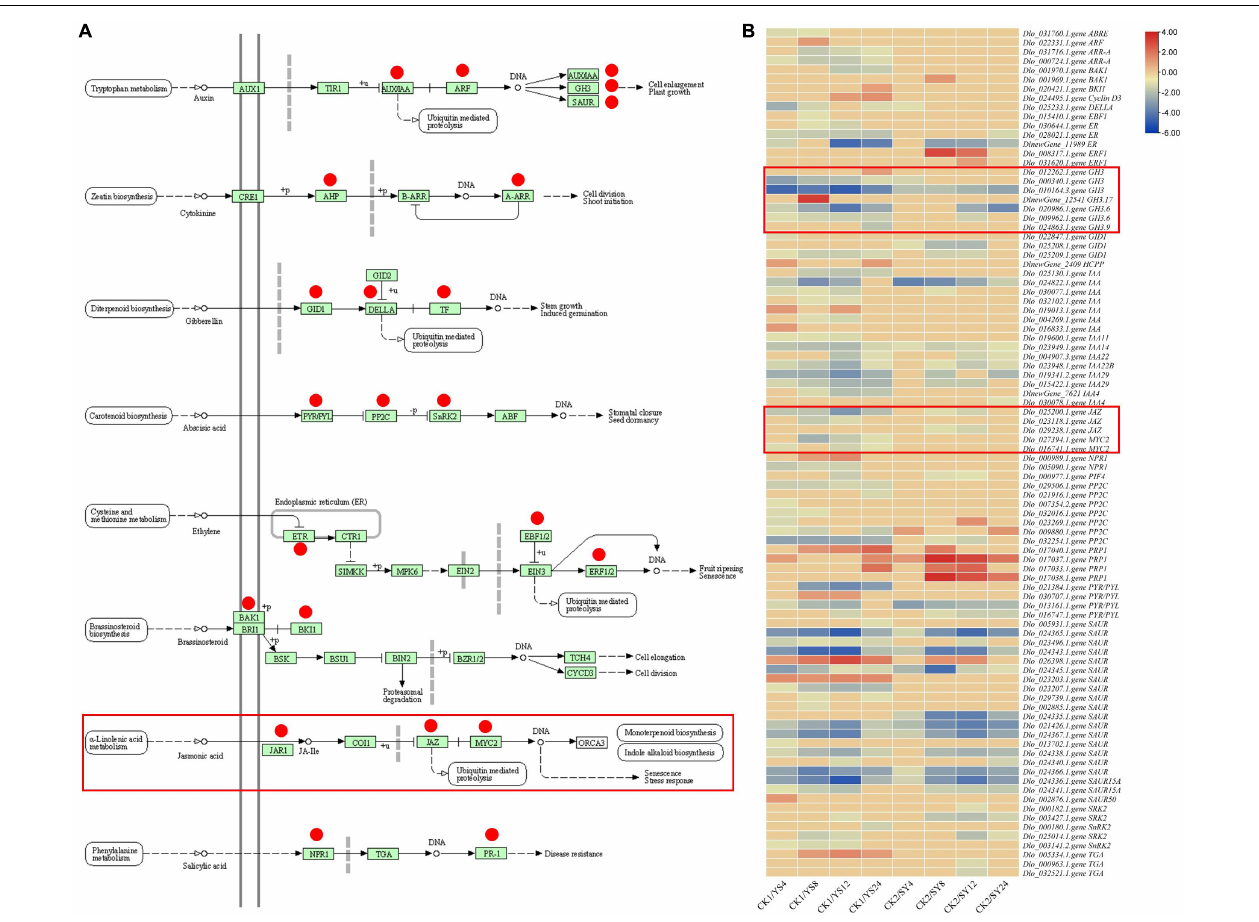
FIGURE 6 | Comparison of hormone signal transduction pathway in the two longan pollination combinations. (A) Regulation of plant-hormone signal transduction pathway in two longan pollination combinations, i.e., YS and SY, compared to their respective controls. Y, Yiduo; S, Shixia; CK1, Yiduo sepal-pistil before pollination; CK2, Shixia sepal-pistil before pollination. The numbers with treatments represent the time (hour) after pollination. The red circles in the left panel represent the genes that were differentially regulated. Red rectangles represent the genes related to Jasmonic acid. (B) The right panel shows the heatmap of log2 fold change values of the DEGs between YS (4, 8, 12, and 24 HAP) vs. CK1 and SY (4, 8, 12, and 24 HAP) vs.